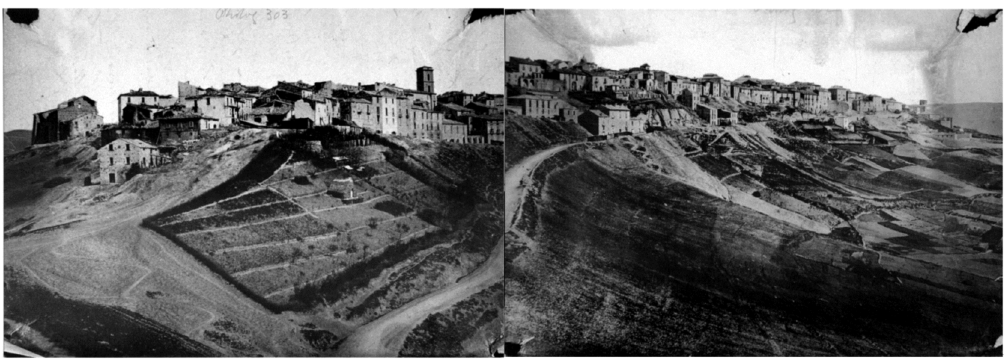
Fig. 2. General view of Potenza after the 1857 seismic event according to the Mallet’s report (Mallet, 1862) (from the monoscopic photos no. 302 and